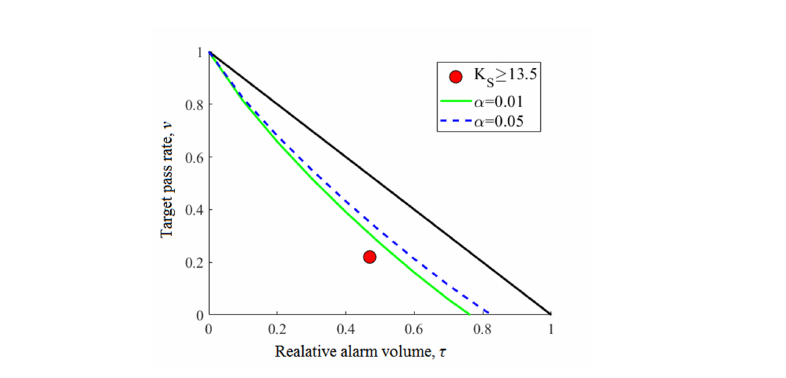
Figure 5. The diagram of errors for the algorithm of the complex ionospheric precursors for K S ≥ 13 . 5.The lower bounds of the confidence interval of the random forecast with the significance level are marked α = 0 . 01 and α = 0 .